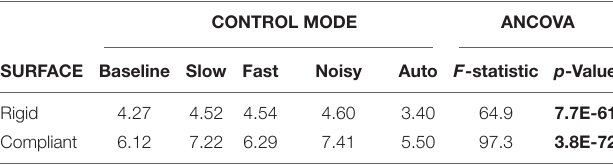
TABLE 1C | Linear regression results on intercept (N − 1 ) for each control mode and ANCOVA results across control modes for each surface.